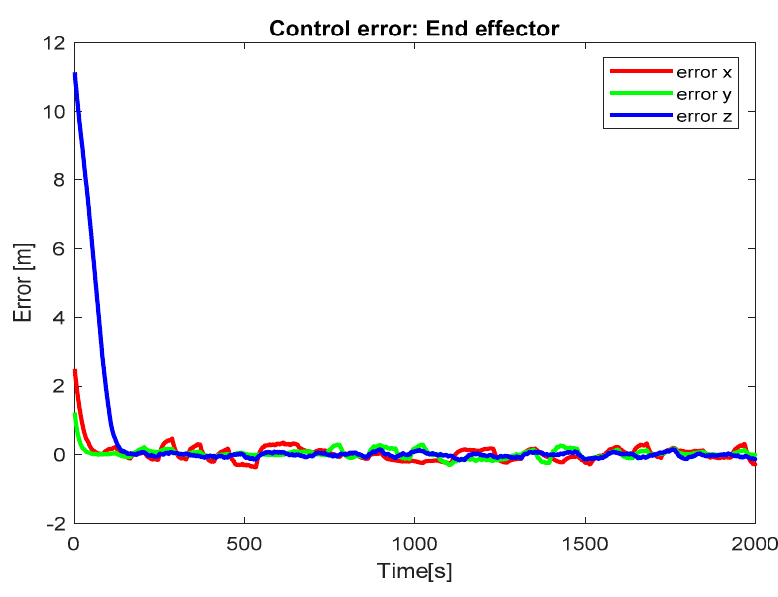
Figure 13. Control errors: SMC controller.